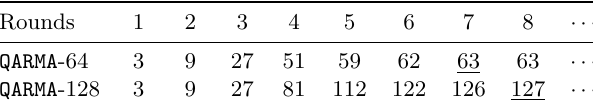
Table 6: Upper Bounds on the Algebraic Degree of